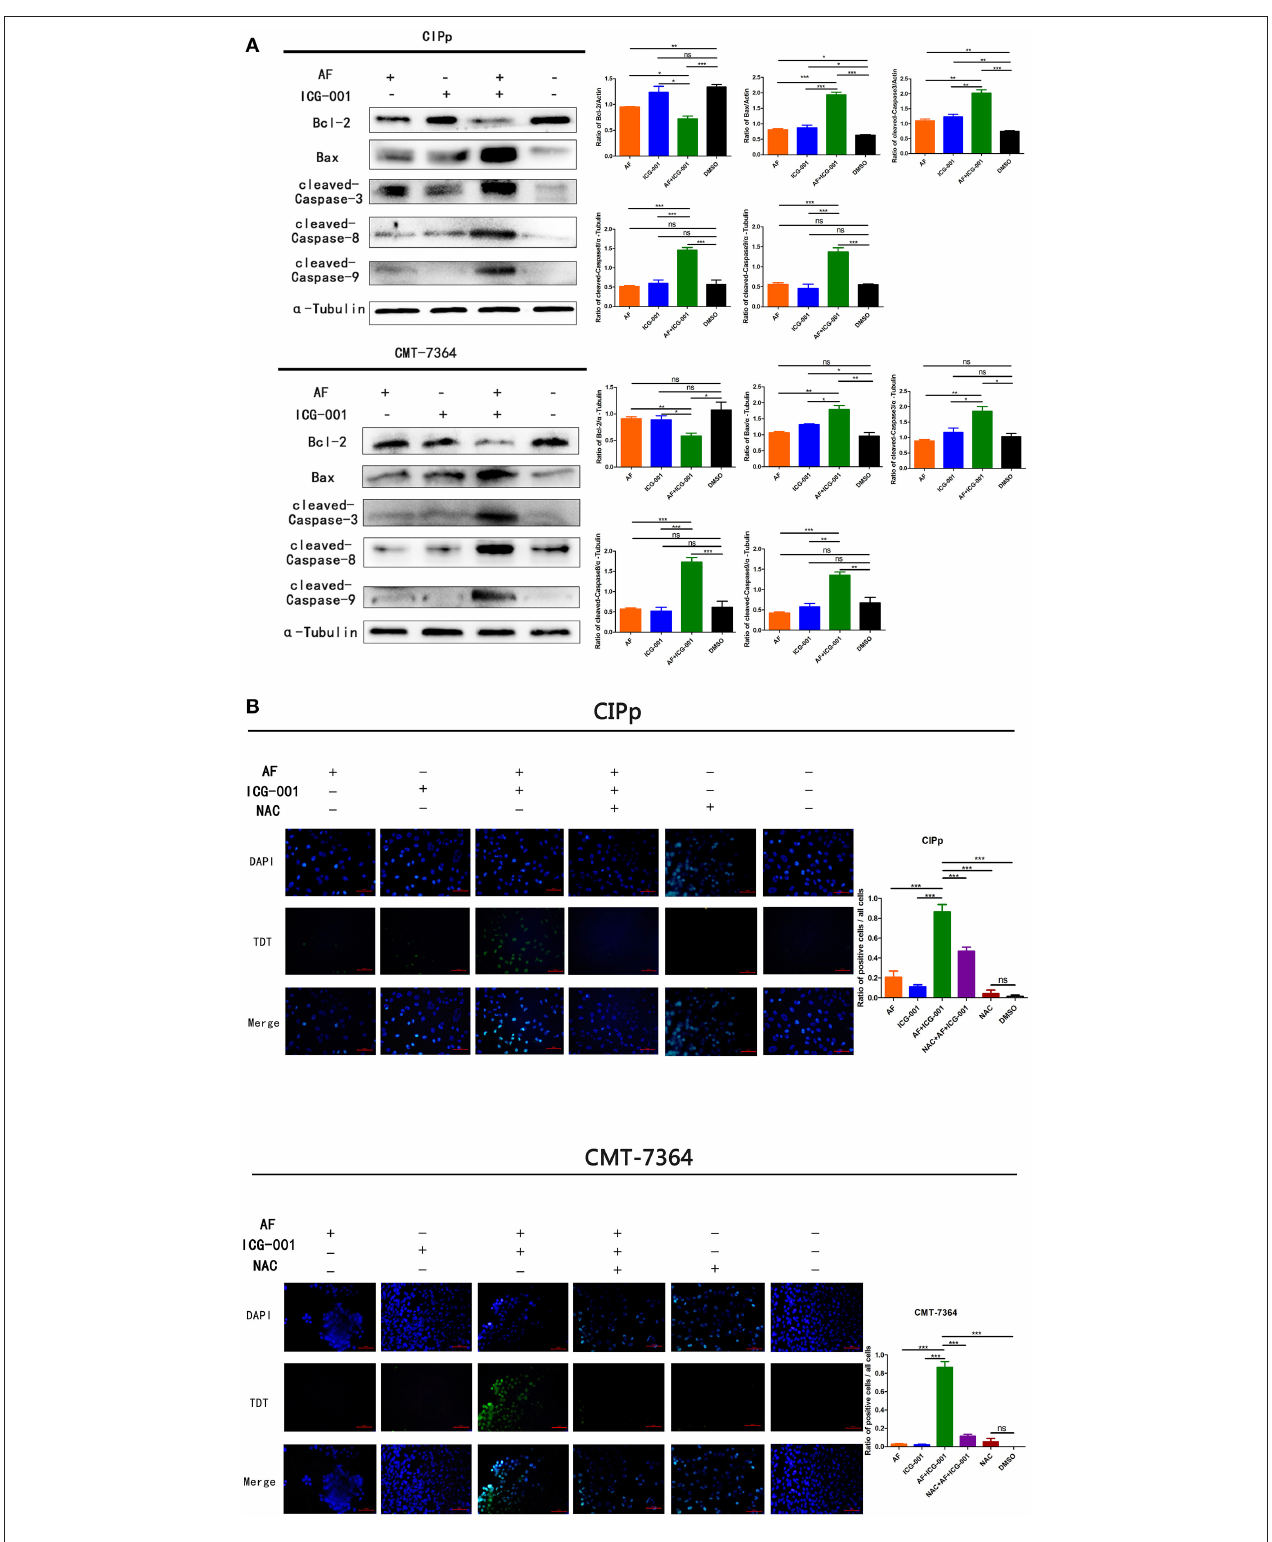
FIGURE 6 | The combination of AF and ICG-001 induces cell apoptosis. Western blot (A) and TUNEL (B) results indicated that the combination of AF and ICG-001 induced cell apoptosis of CIPp and CMT-7364 cell lines. Data were representative of three independent experiments. p -values: * p < 0.05; ** p < 0.01; *** p < 0.001; ns,